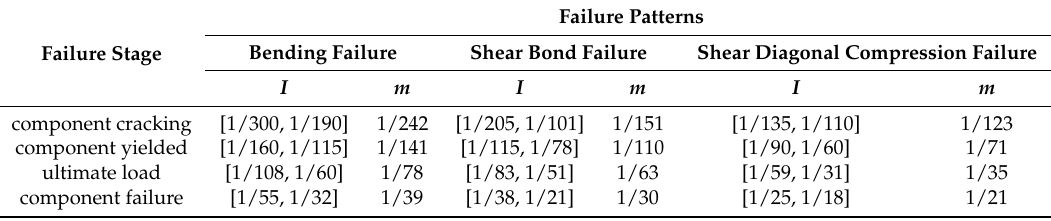
Table 2. The distribution value of inter-story drift of steel reinforced high strength high performance concrete (SRHPC) frame columns under different failure